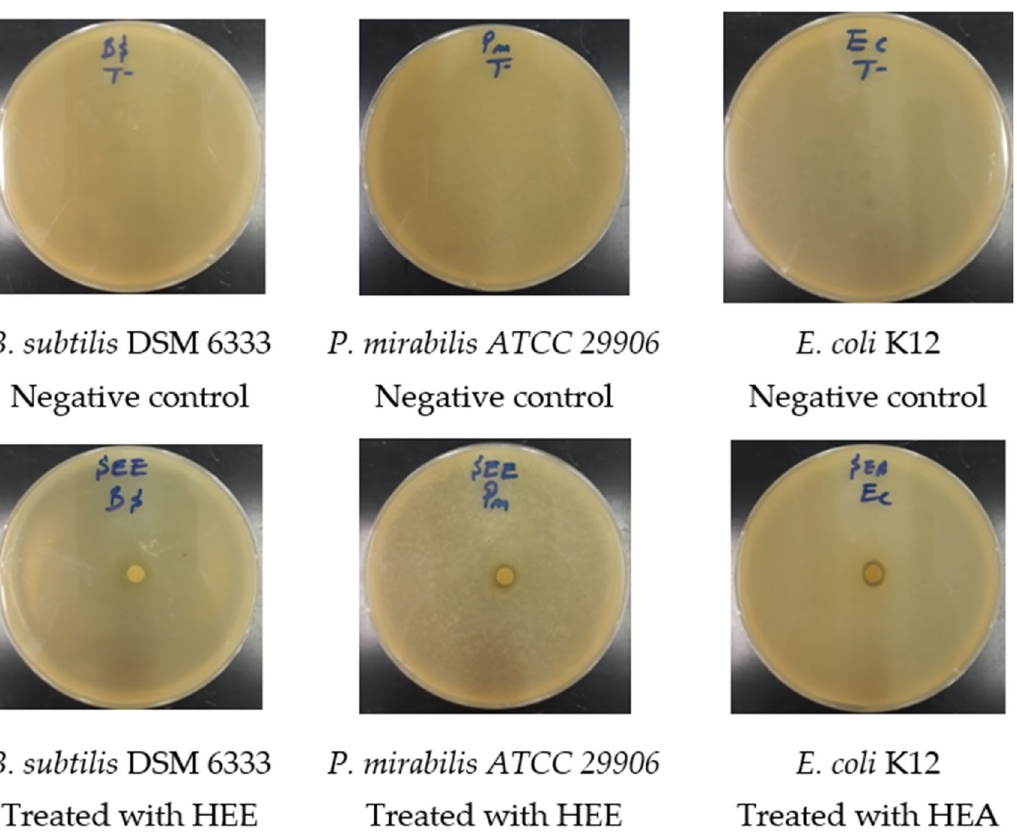
Figure 6. Photographs showing the effects of extracts on some of the bacteria tested. Table 4. MIC of antimicrobial activity of S. elaeagnifolium HEE and